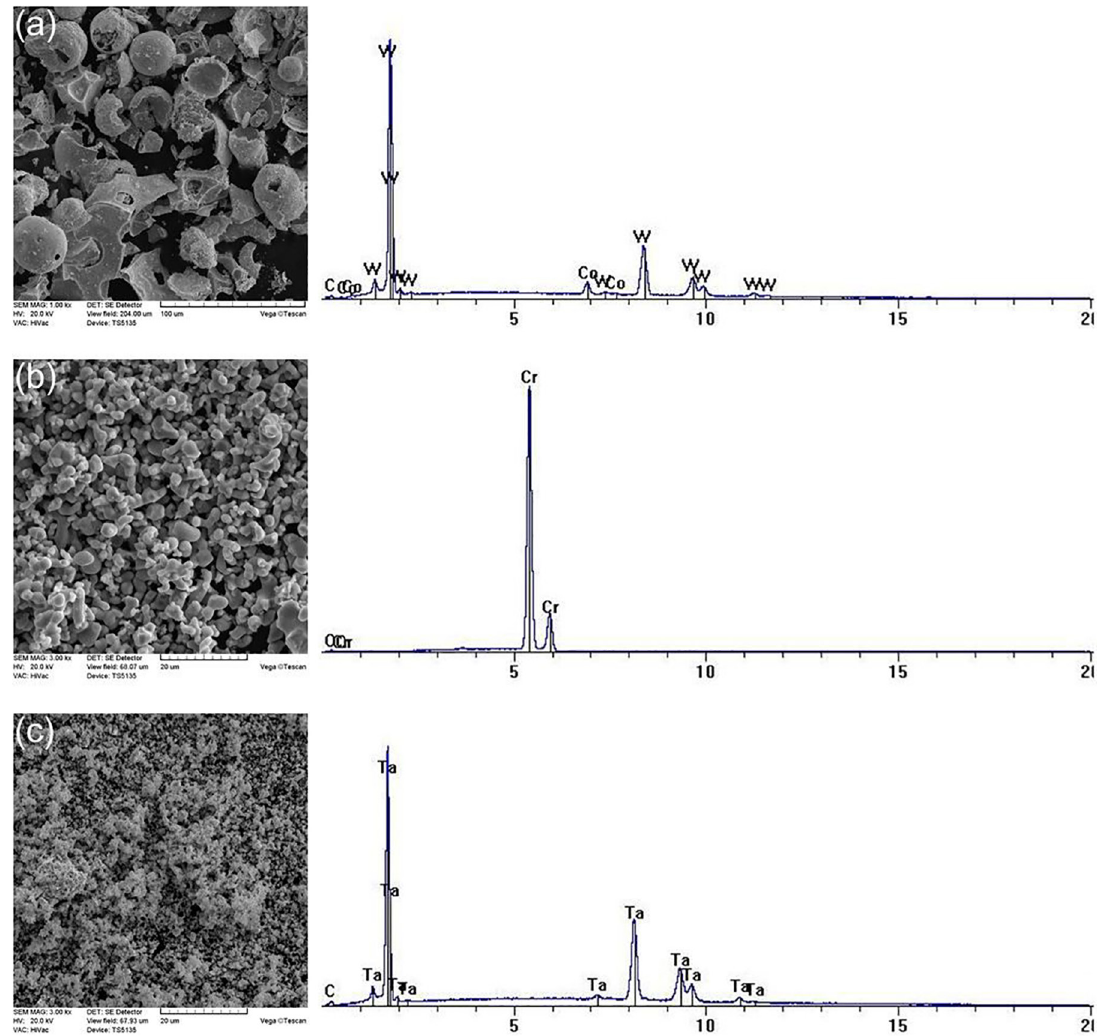
C and (c) TaC, various 3 2